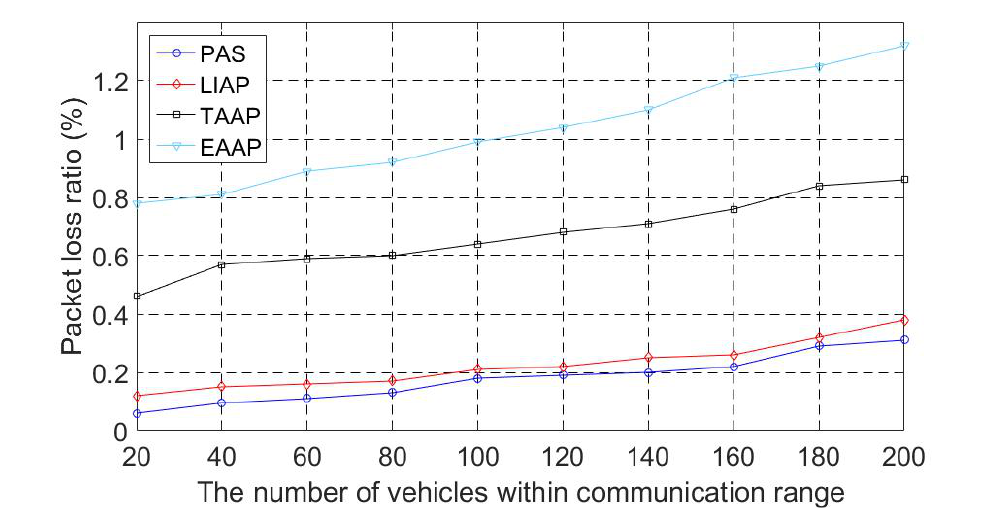
Figure 10. Packet loss ratio of each